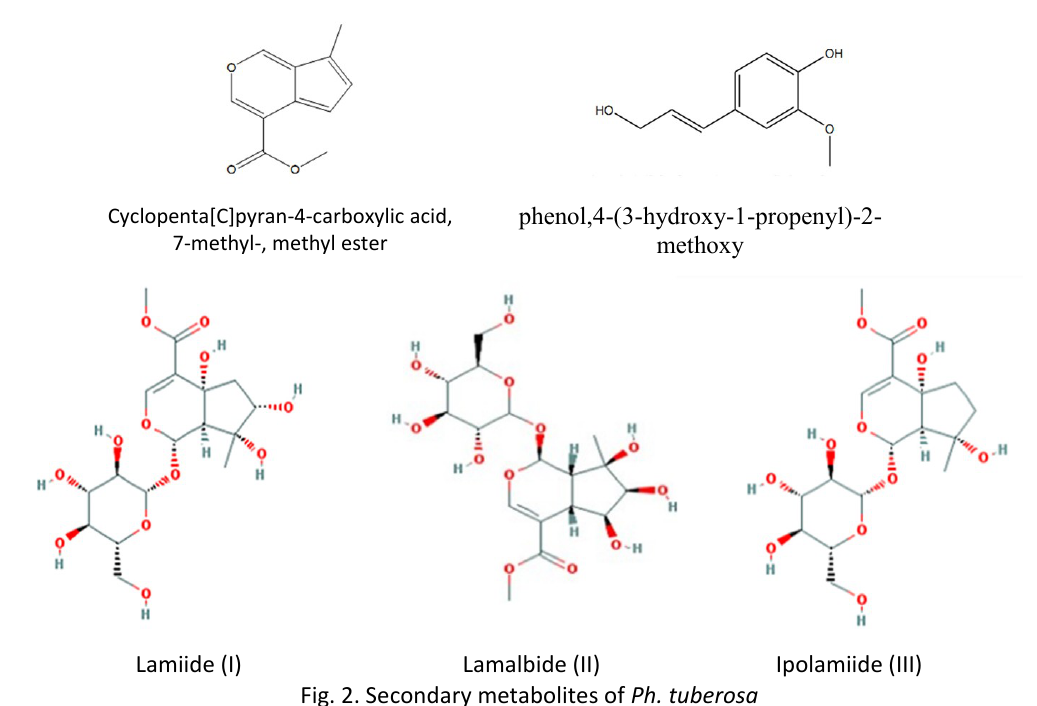
phenol,4-(3-hydroxy-1-propenyl)-2- Cyclopenta[C]pyran-4-carboxylic acid, 7-methyl-, methyl ester methoxy Fig. 2. Secondary metabolites of Ph. tuberosa